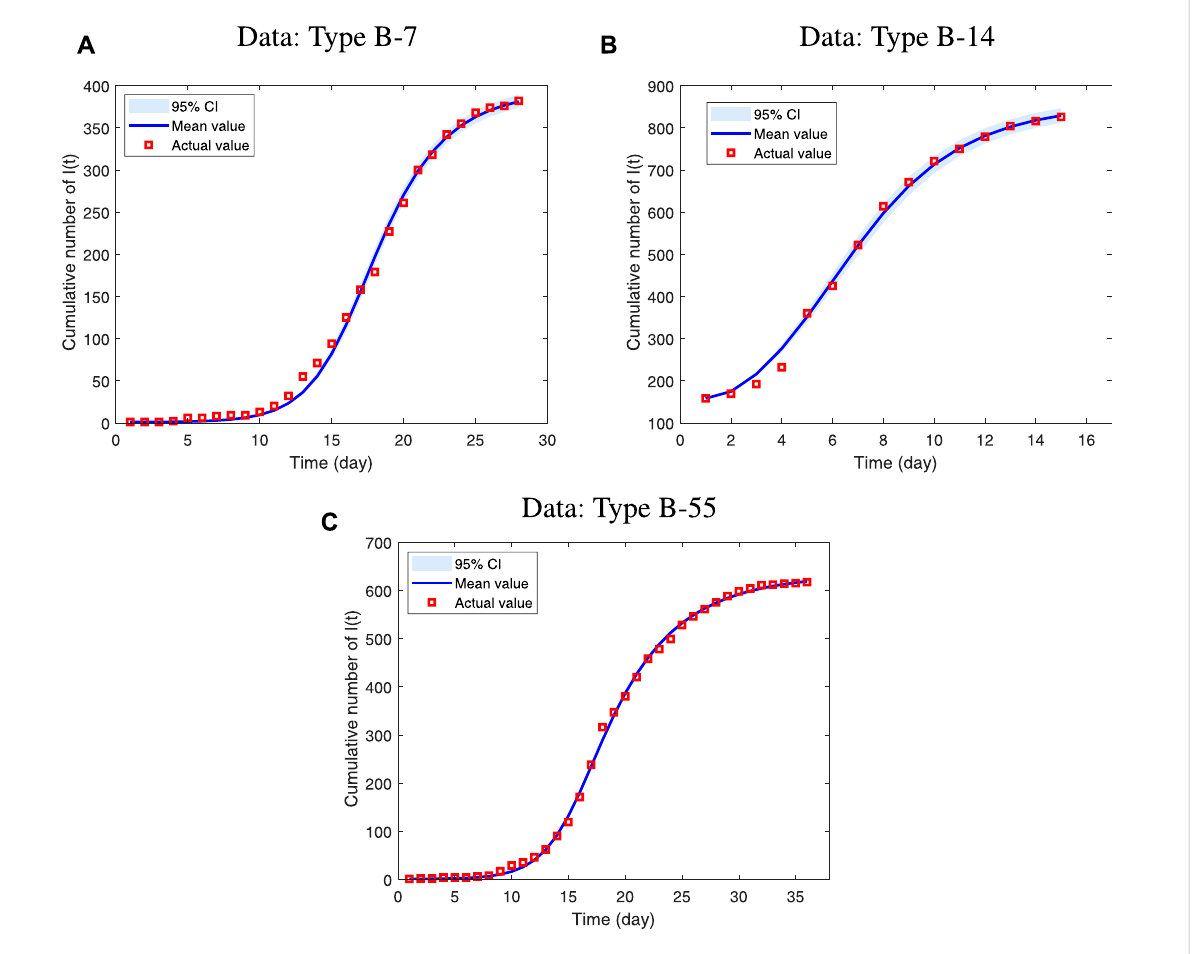
FIGURE 2 MCMC fi tting results ofcumulative symptomaticallyinfectedcases inthree typesof data respectively, where Red squares are represent thereal data and blue lines are fi tting curves. (A) The data type is B-7 and it happened at a school in Tangshan. The onset time was from 2019.01.26 to 2019.02.22. (B) ThedatatypeisB-14andithappenedataschoolinDunhuang.Theonsettimewasfrom2014.12.26to2015.02.02 (C) Thedatatypeis B-55 and it happened at a school in Baoding. The time of the disease was from 2012.01.24 to